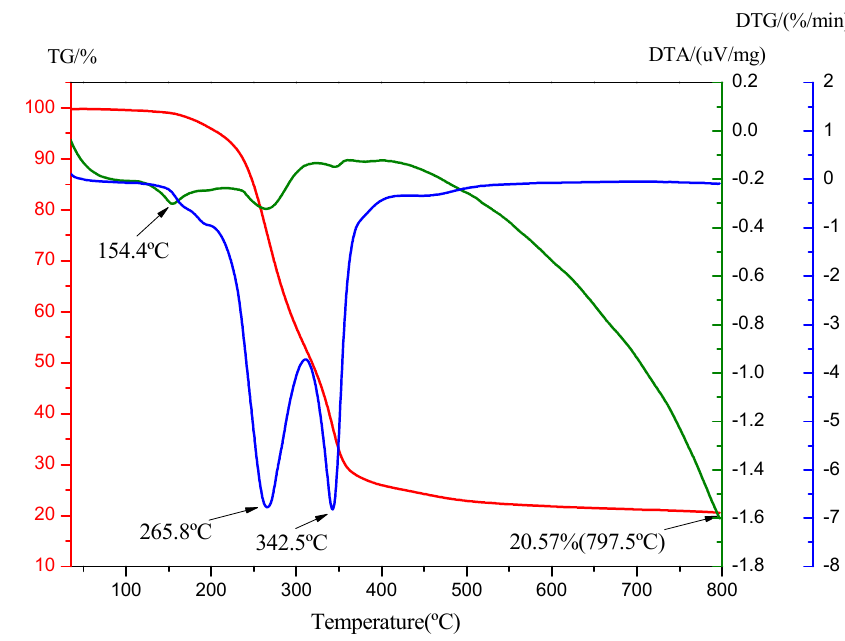
Figure 2. Thermogravimetric analysis (TGA), differential thermal analysis (DTA), and derivative thermogravimetry (DTG) curves of the targeted DMAE-Zn.